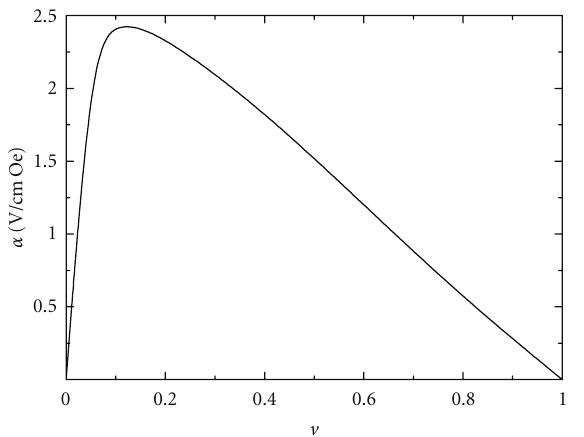
Figure 11: ME e ff ect in bulk composite of NFO and